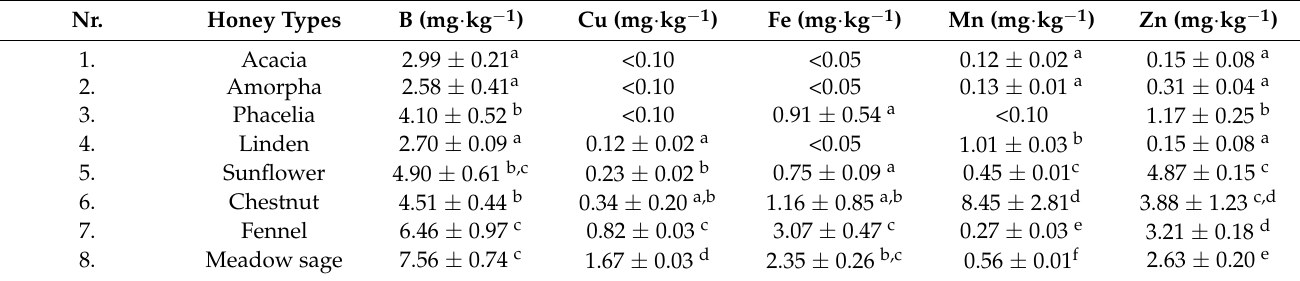
Table 4. Microelement content of honey